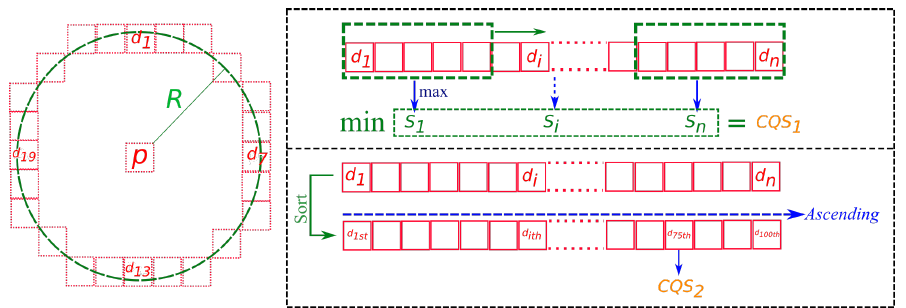
Figure 8. The Contrast Quality Score ( CQS ). p is the intensity value, d is the difference in intensity value. CQS 1 is the contiguous contrast and CQS 2 is the global contrast